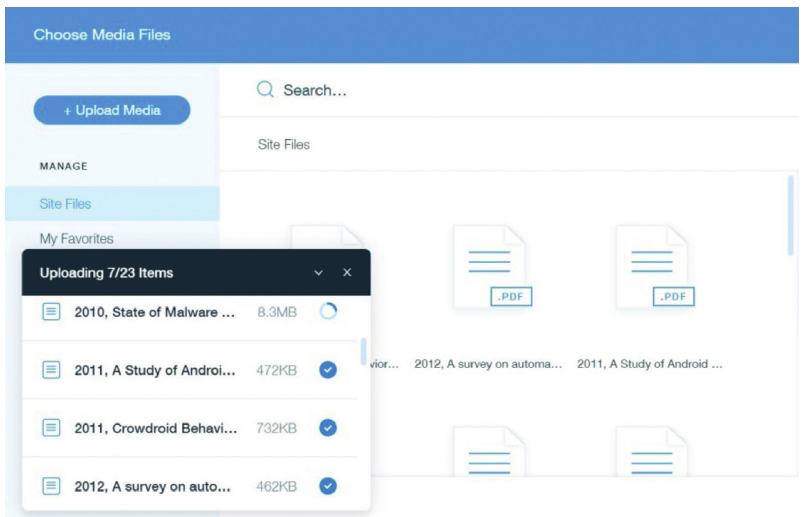
Figure 3: Files getting uploaded on